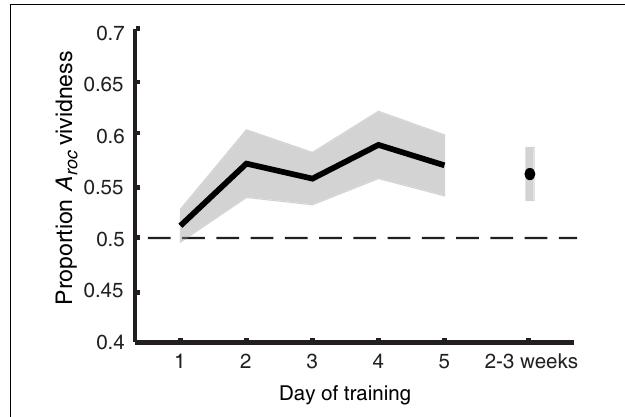
FIGURE 5 | Imagery metacognition improves over the course of training. The extent to which self-reported vividness predicts perceptual bias (quantified as the area under the ROC II curve after collapsing all grating orientations, as also shown in Figure 4 ) plotted against day of training. Shaded areas represent ± 1 SEM.